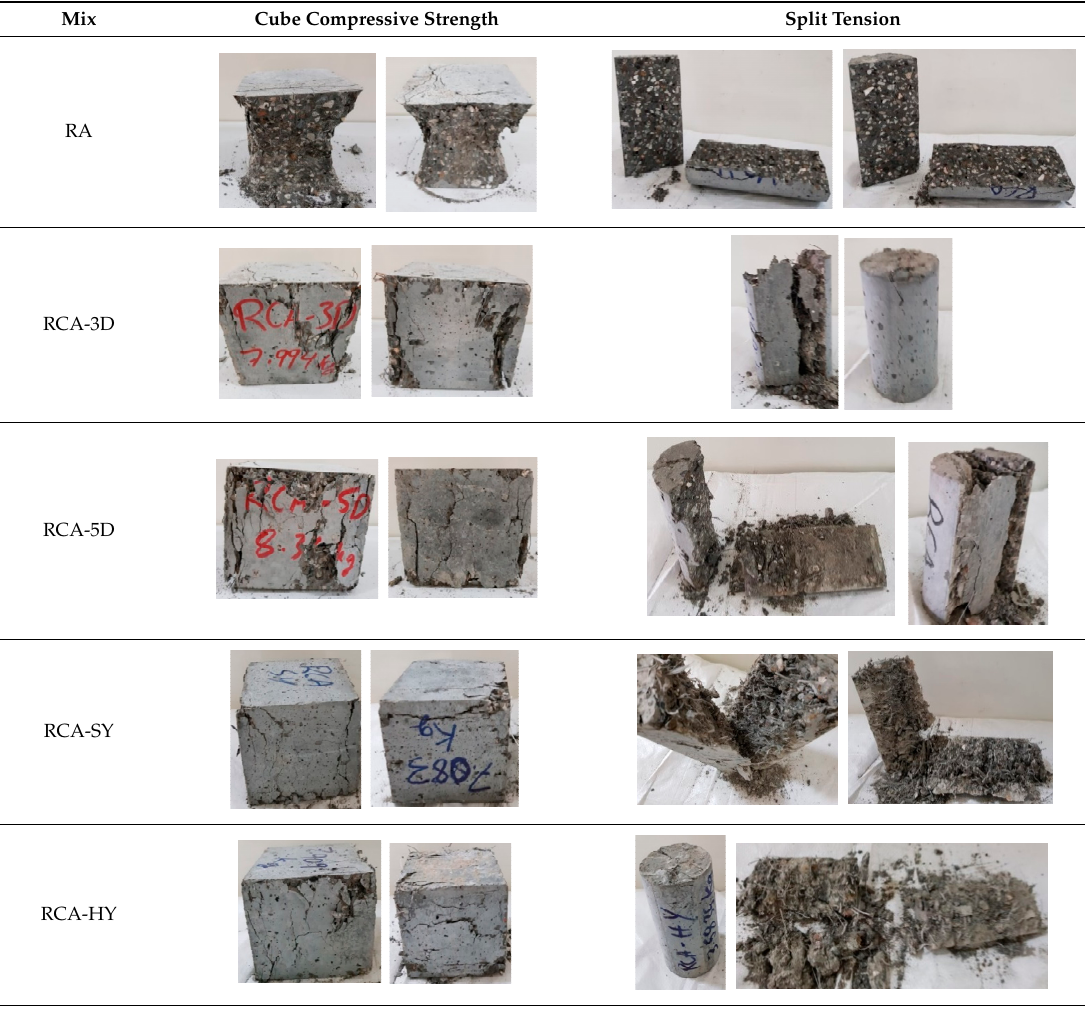
Table 7. Summary of the 90-day mechanical properties results.